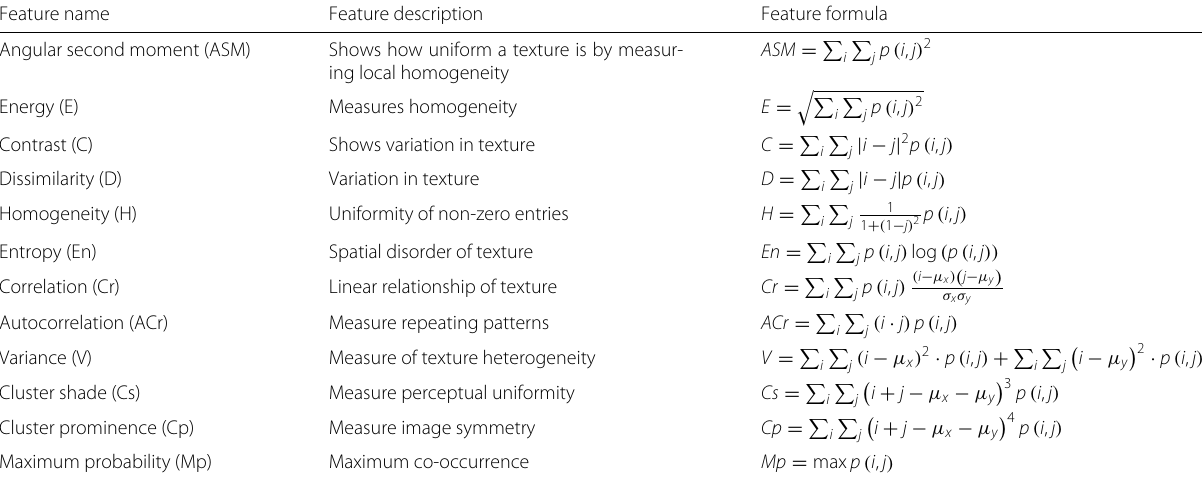
Table 1 Summary of Haralick